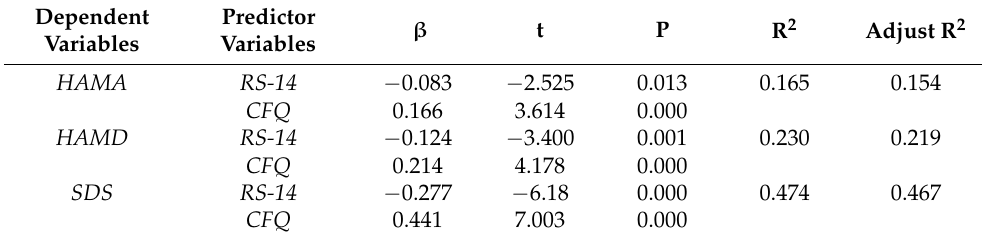
Table 4. Results of regression analysis of psychological resilience, cognitive fusion, anxiety, and depression. Dependent Variables